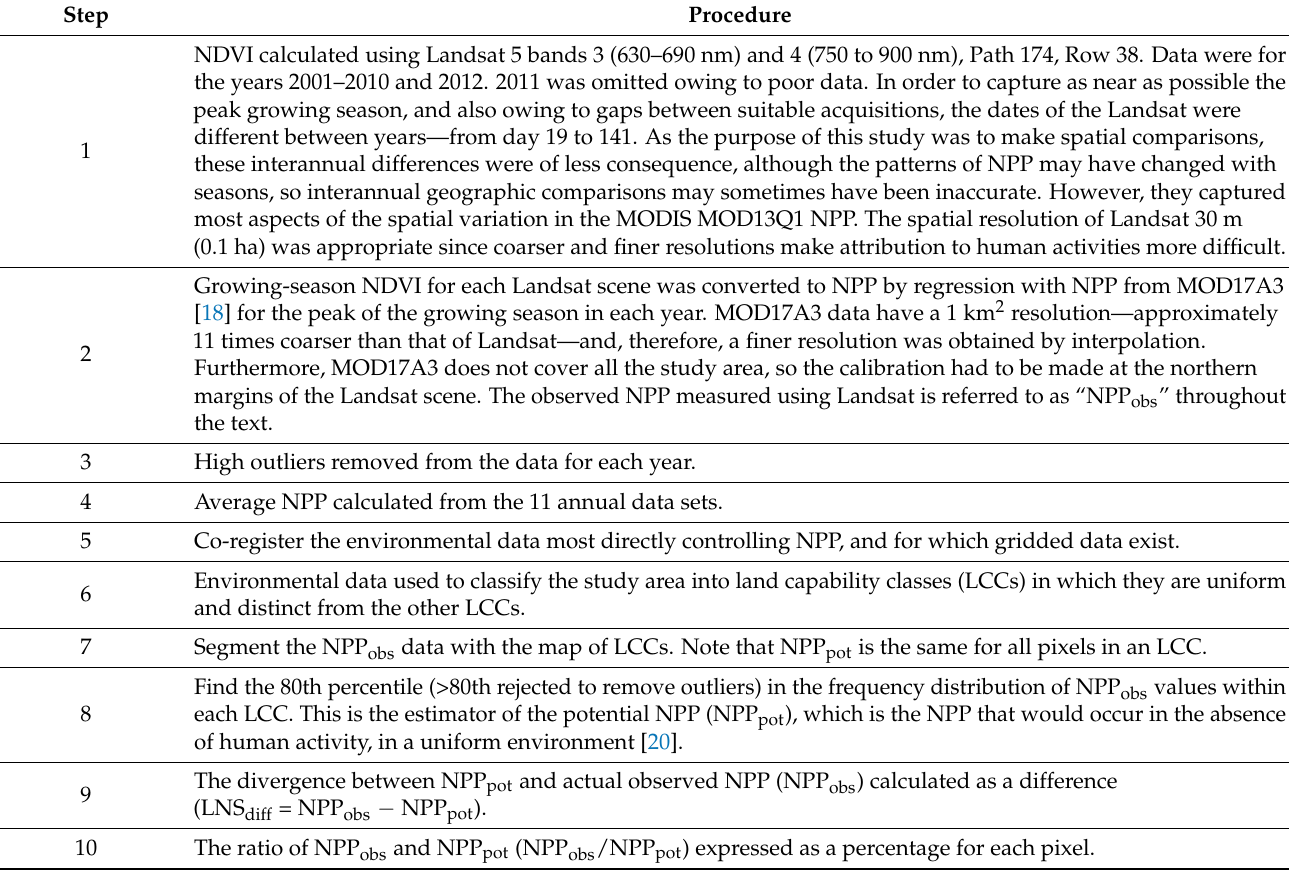
Table 2. Data processing